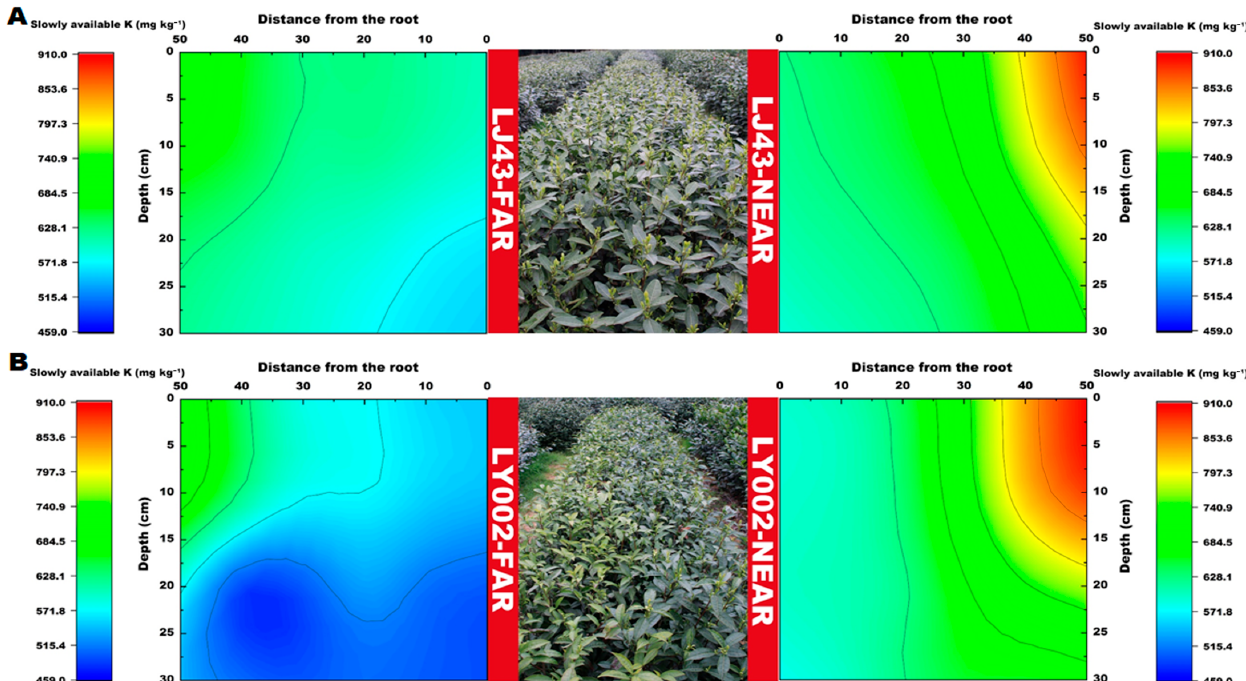
Figure 5. Variation in soil slowly available K content related to LJ43 and LY002 with different treat- ments. A : LJ43; B : LY002. Data shows the mean ± standard deviation ( n = 3).